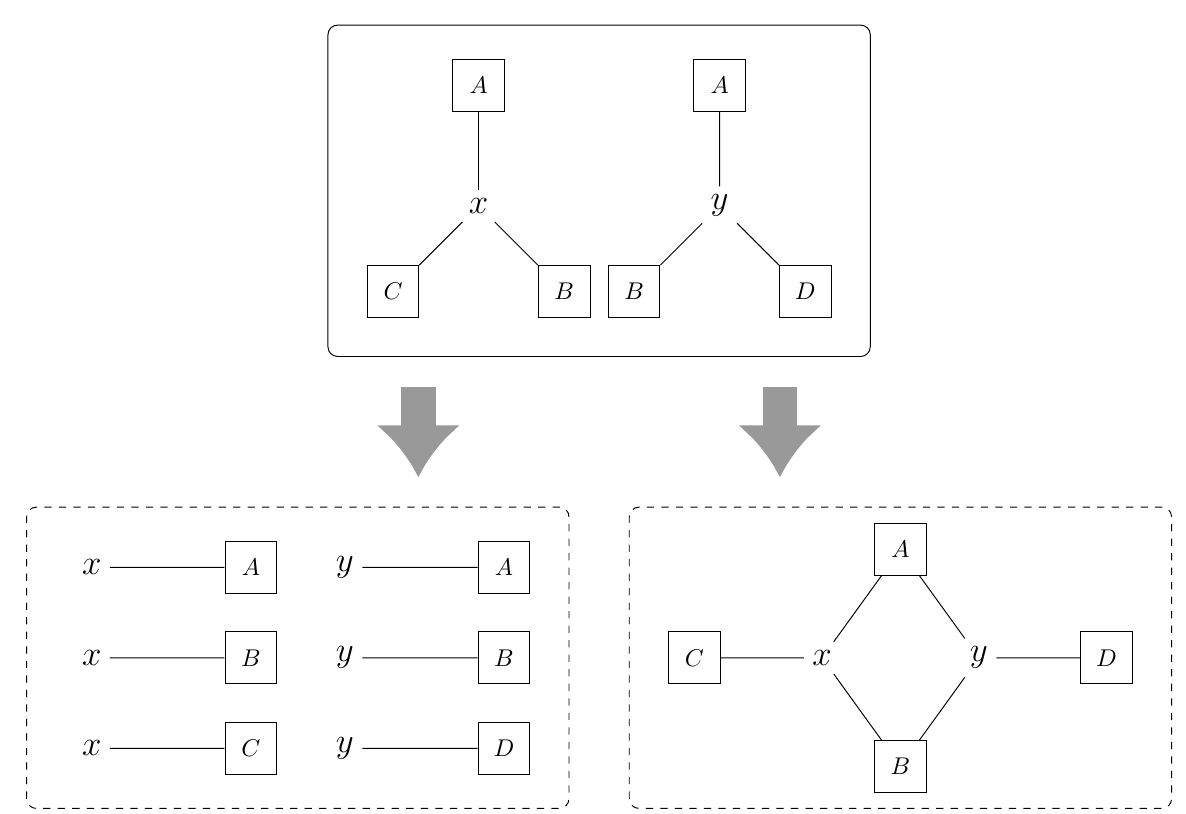
Figure 1: Illustration of approach to analyze ego-centric network data. Notes: Respondents are represented by lowercase letters, whereas groups are represented by uppercase letters in